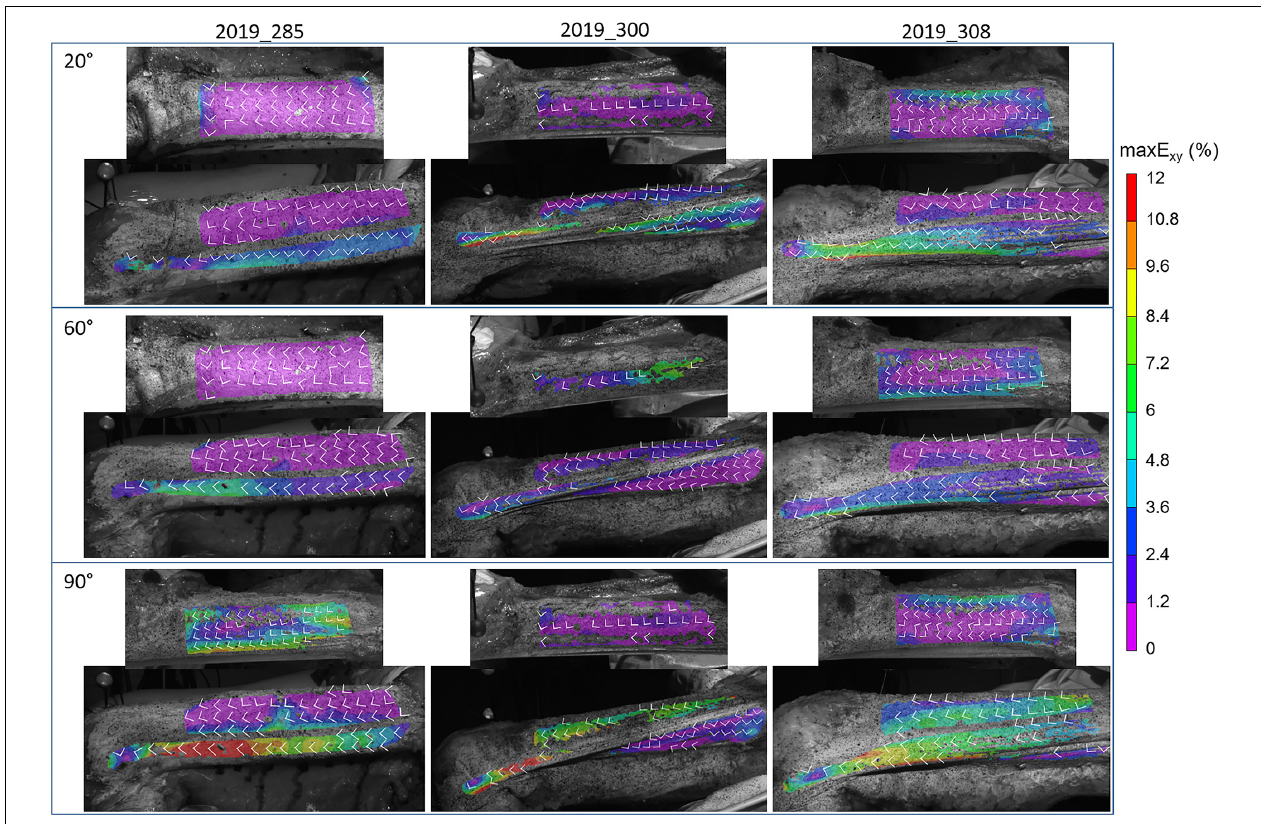
FIGURE 4 | Maximal shear strain distribution maxE xy on the anterior fascia, lateral fascia, and ITT, at knee angles of 20 ± 0.5 ◦ , 60 ± 0.5 ◦ , and 90 ± 0.5 ◦ for all subjects (Test 2). White arrows show the direction of the major E 1 and minor E 2 principal strains, which are perpendicular to each other. For instance, for the first line knee angle is 20 ◦ , the top images are anterior fascia, while lower images show lateral fascia and